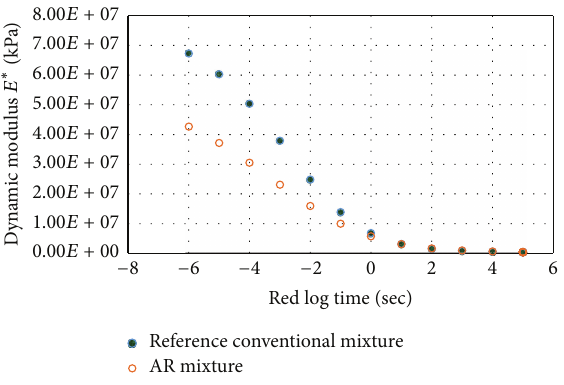
Figure2:Average 𝐸 ∗ MasterCurvesforHMAandARmixtures[13].